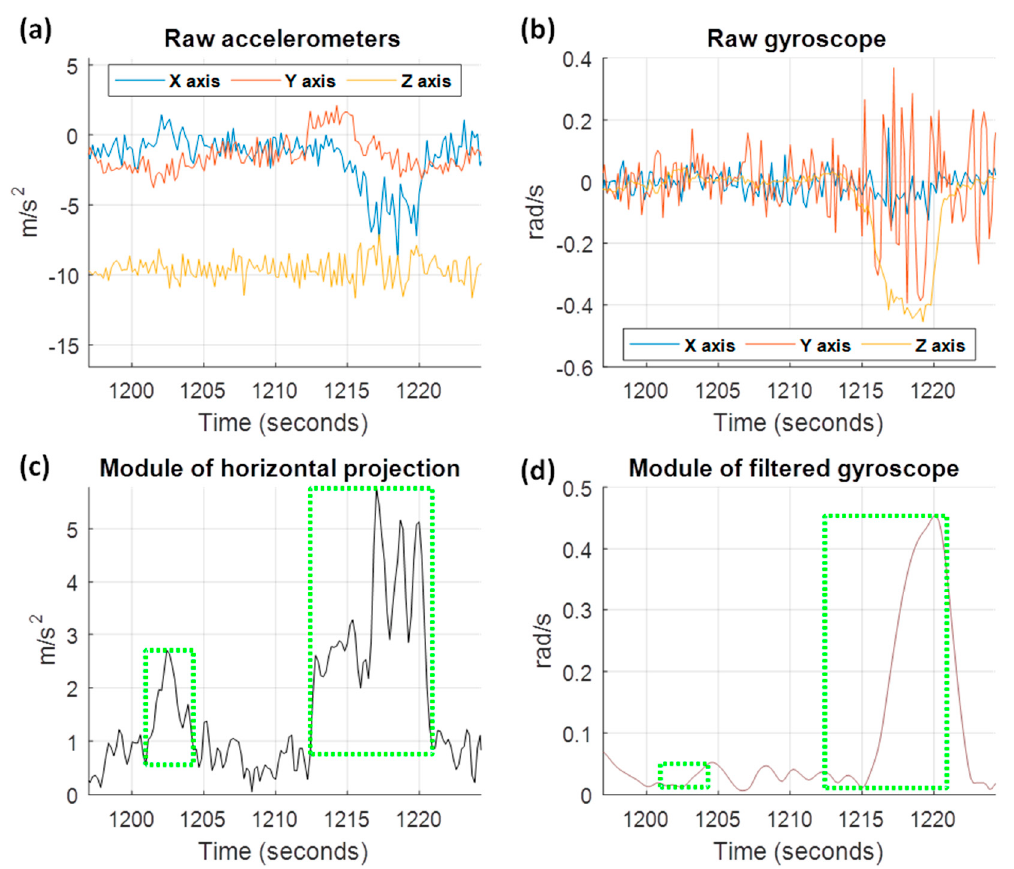
Figure 3. Signals corresponding to two maneuvers detected during a driving journey. ( a ) Raw accelerometers. ( b ) Raw gyroscope. ( c ) Horizontal projection module. ( d ) Module of filtered gyroscope.